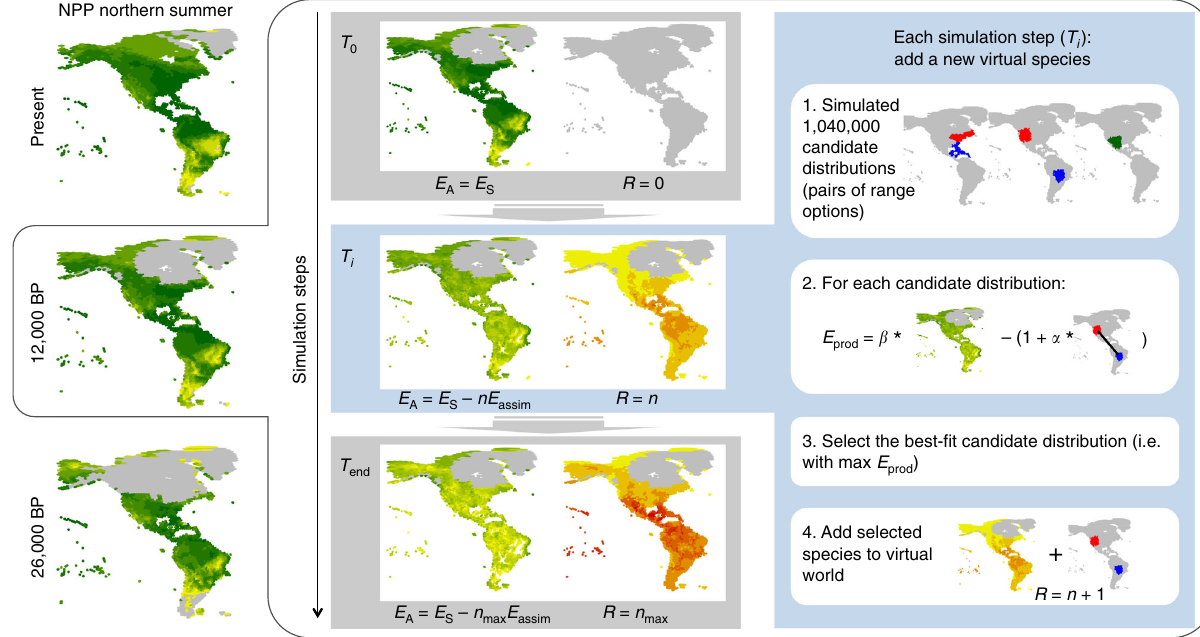
Fig. 1 Model description. The SEDS model was applied to each time slice of a climate reconstruction from present to 50,000 before present (BP); i.e., every 1000 years from present to 22,000 BP and every 2000 years before 22,000 BP. For a given time slice (example of 12,000 BP in this fi gure), the simulation starts ( T 0 ) with a virtual world empty of bird species ( R = 0). At this point, the energy available to birds is equal to the energy supply ( E A = E S ), estimated from the net primary productivity (NPP) obtained from the climate reconstruction. In each simulation step (T i , sub-steps 1 to 4) a new virtual species is added to the virtual world. Its geographical distribution (combination of a breeding range and a non-breeding range) is selected among 1,040,000 candidate distributions, which are pairs of range options. Each range option is seeded randomly across the world and grown until a fi xed size using a stochastic algorithm constrained by climatic conditions (see Methods; sub-step 1). The candidate distribution with the highest energetic fi tness (i.e., maximum value of energy used for production, E prod ) is selected (sub-steps 2 and 3). E prod is computed as the energy assimilated by the species ( E assim ), which is a linear function of the energy available within the geographical ranges ( β E A , type I functional response), minus energetic costs, which is equal to 1 (the basal energy used for survival) plus a linear function of the migration distance ( α = 6.45e − 5 , see Methods). This way, the model optimises the balance between the energy assimilated through access to energy supplies and the energy used for travelling to determine the species ’ seasonal geographical distributions. As this new species is added to the virtual world ( R = n + 1; n indicating the total number of species at the start of a simulation step), the energy available E A is further depleted in the corresponding breeding and non-breeding ranges (sub-step 4). The simulation ends ( T end ) when, after n max species are simulated, the maximum value for E prod is negative, meaning that any new virtual species would not have access to enough energy to compensate for the energetic costs associated with survival and therefore cannot